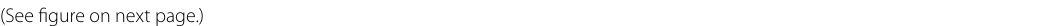
figure on next Fig. 1 The electroencephalogram on postoperative day 7. An alpha-dominant pattern at 11 a.m. A changed into a delta-dominant pattern with high-amplitude on bilateral forehead at 4 p.m. B . Reduced amplitude with asymmetric suppressed/delta-dominant pattern detected on left forehead at 7 p.m. C . L1, R1, L2, and R2 are labels of the electrodes. L1 and R1 are affixed to the bilateral forehead above the eyebrows, and L2 and R2 are affixed to the hairless area at the upper region of the bilateral temples. The amplitude range is